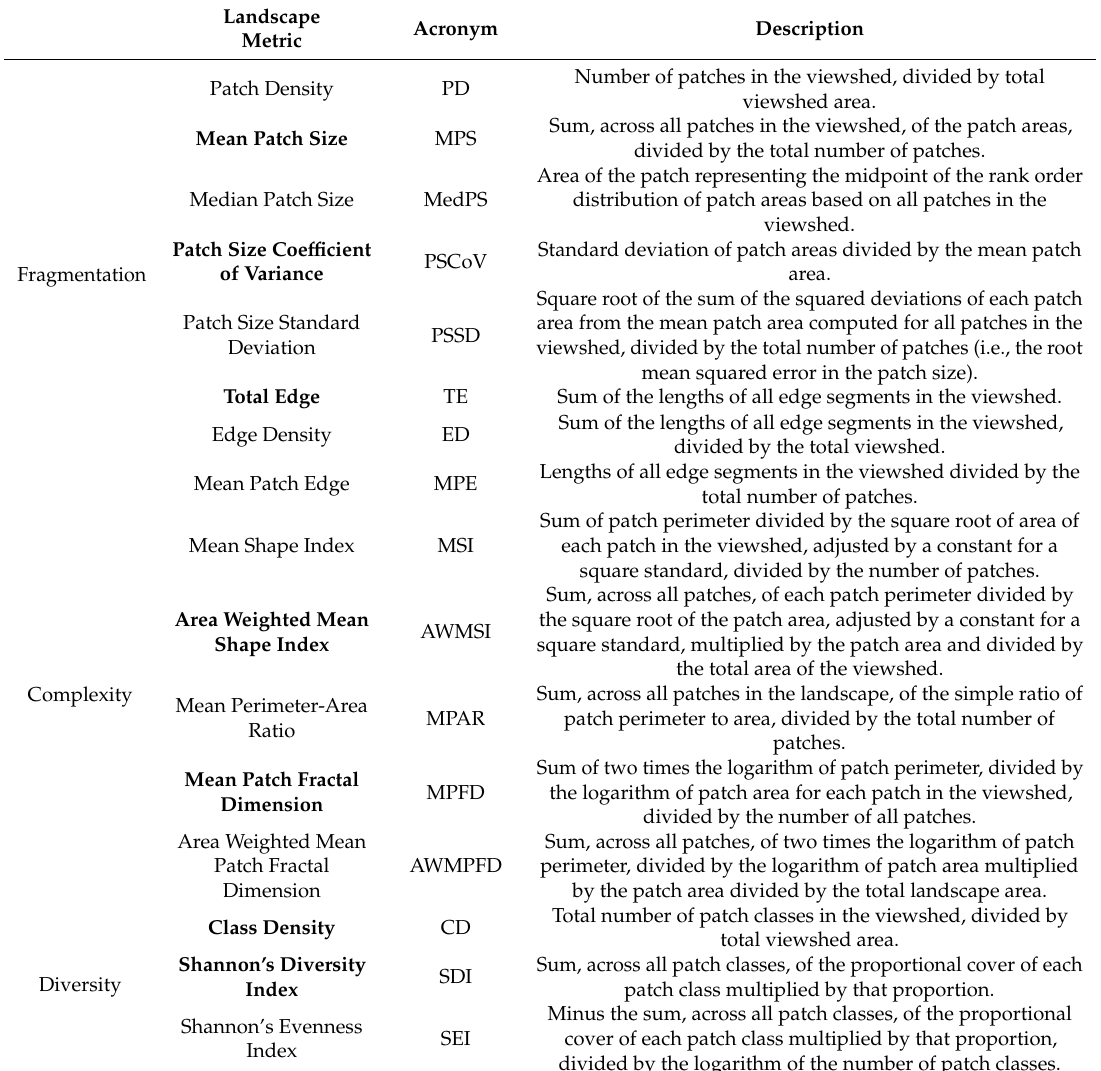
Table A2. Overview of the 16 landscape metrics [27] originally considered for the landscape analysis of the 18 viewsheds. In bold, the seven metrics selected after the auto-correlation test and used for the landscape